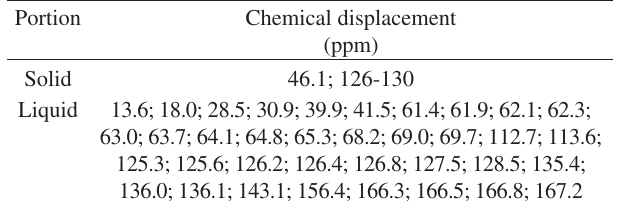
Table 1. 13 C NMR chemical displacements of the cement solid and liquid